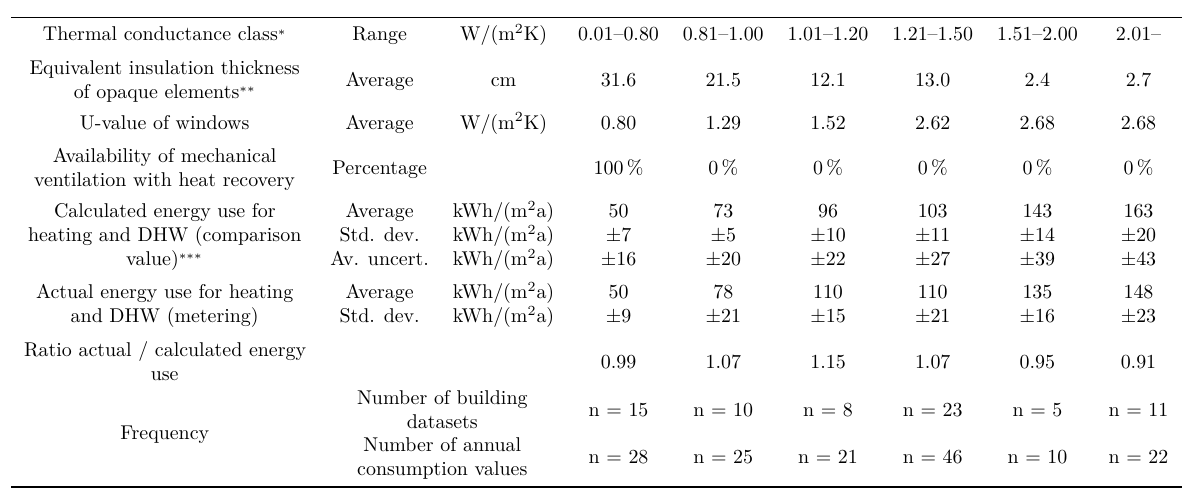
Table 4. Comparison of theoretical and actual consumption for a building sample (heating + DHW). Averages, uncertainties and standard deviations differentiated by thermal conductance class. (Status of database analysis: